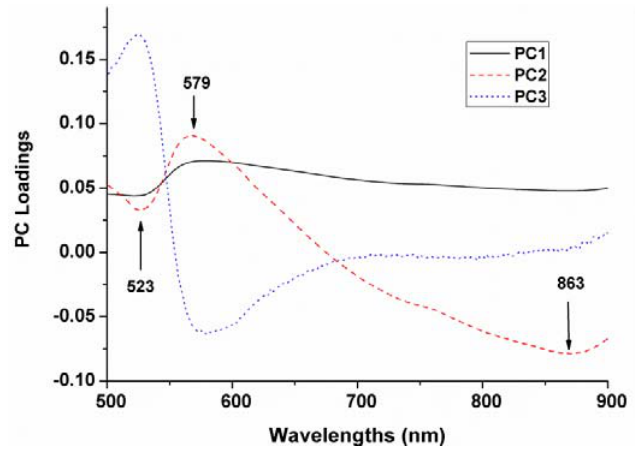
Figure 5. Loading weights of the first three PCs from PCA on ROI images for selecting optimal